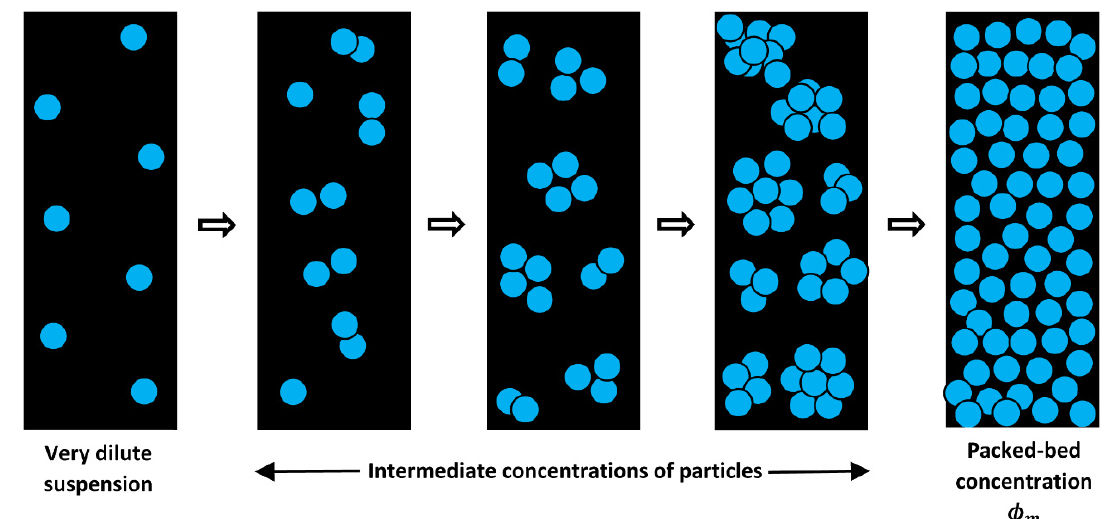
Figure 4. Variation in microstructure of suspension with successive addition of particles.